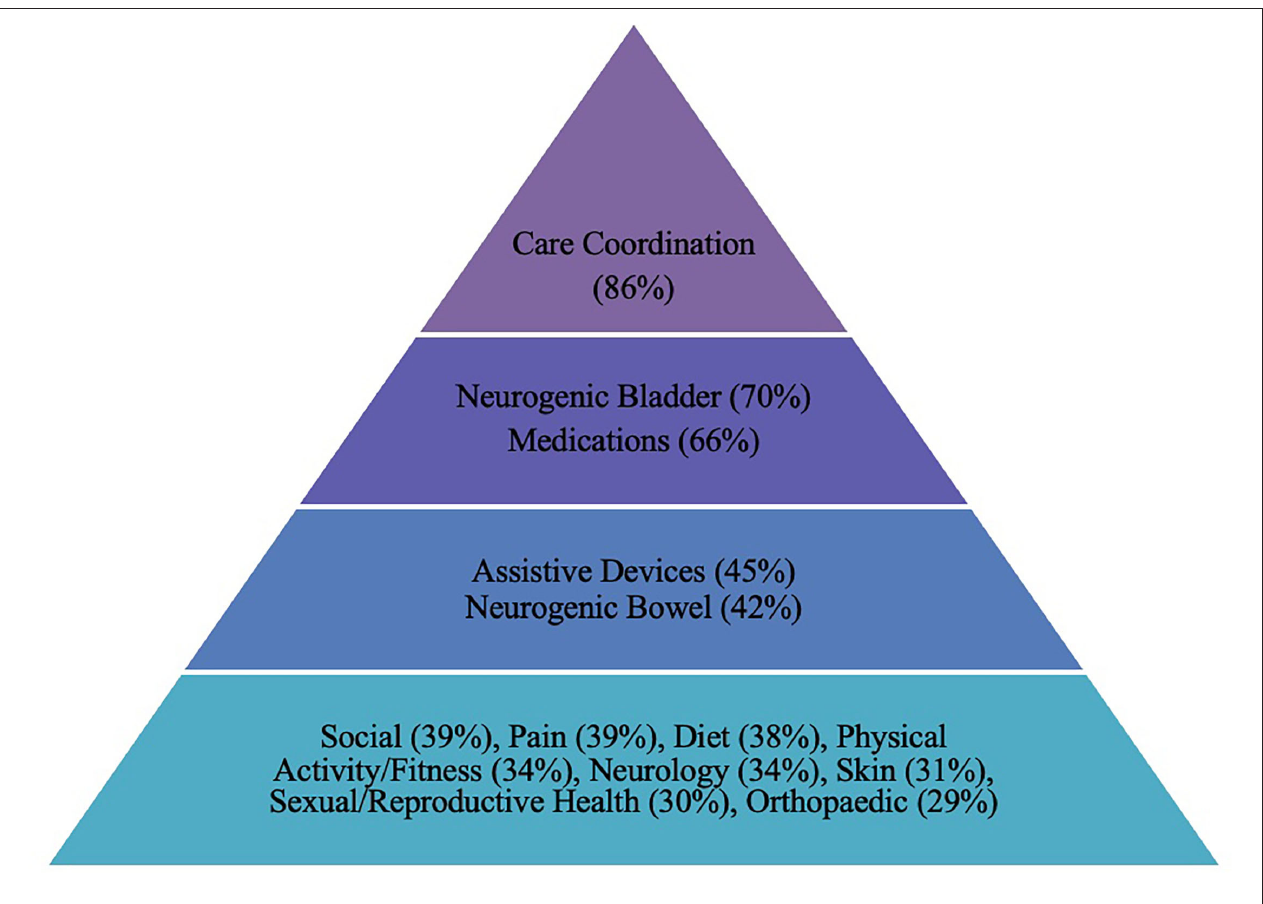
FIGURE 1 | Most common concerns (in